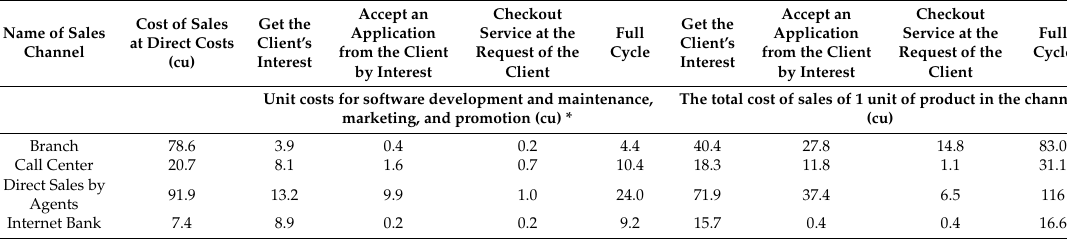
Table 4. Calculation of cost of sales, taking into account the cost of software and marketing.